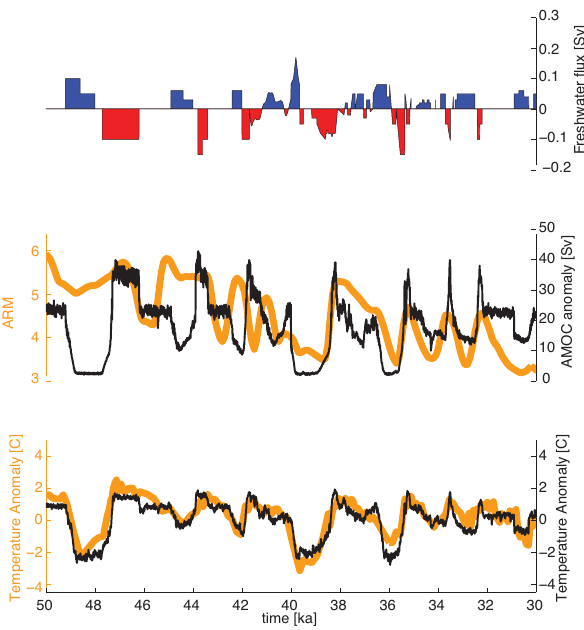
Fig. 2. From top to bottom: time series of North Atlantic freshwater forcing (Sv) applied to LOVECLIM in the region 55–10 ◦ W, 50– 65 ◦ N; simulated maximum meridional overturning circulation in the North Atlantic (Sv) compared to North Atlantic marine sed- iment cores ARM data (Kissel et al., 2008); and simulated SST anomalies off the Iberian margin (15–8 ◦ W, 37–43 ◦ N) compared to alkenone-based SST anomalies from marine sediment core MD01- 2444 (Martrat et al., 2007). Model results are in black and paleo- proxy records in